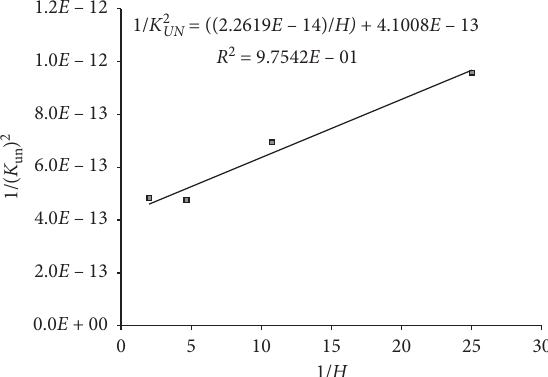
Figure 8: Linear regression for calculating K SEL